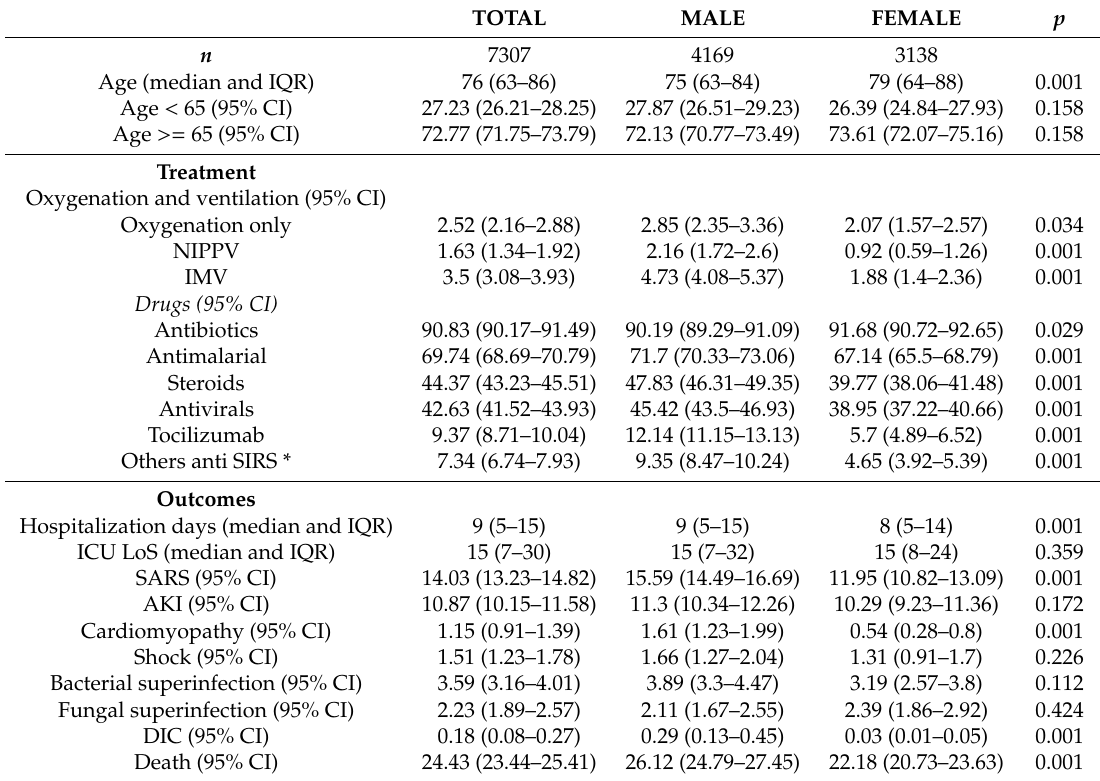
Table 1. Baseline characteristics and clinical outcomes of the hospitalized COVID-19 patients in Castile and Leon (Spain) during the first wave (1 March to 31 May